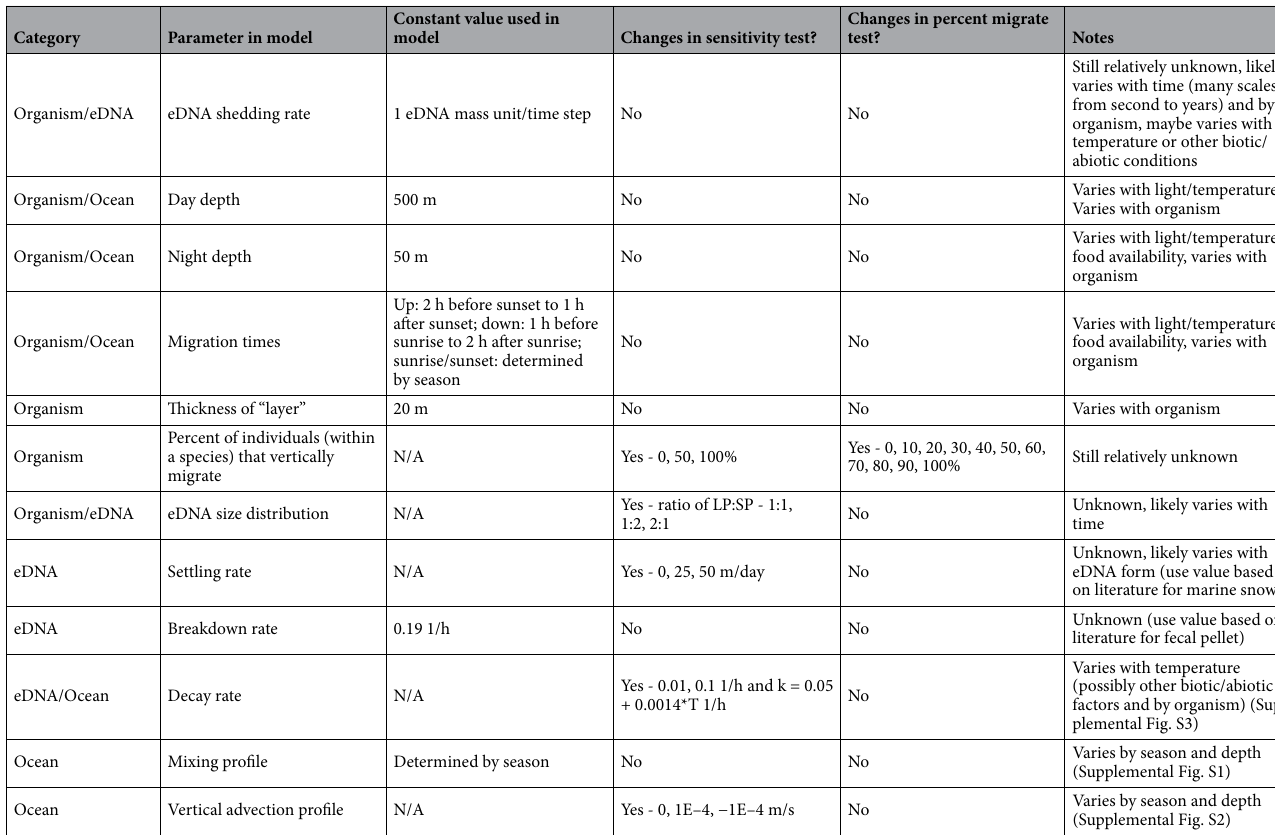
Table 1. Parameters separated by